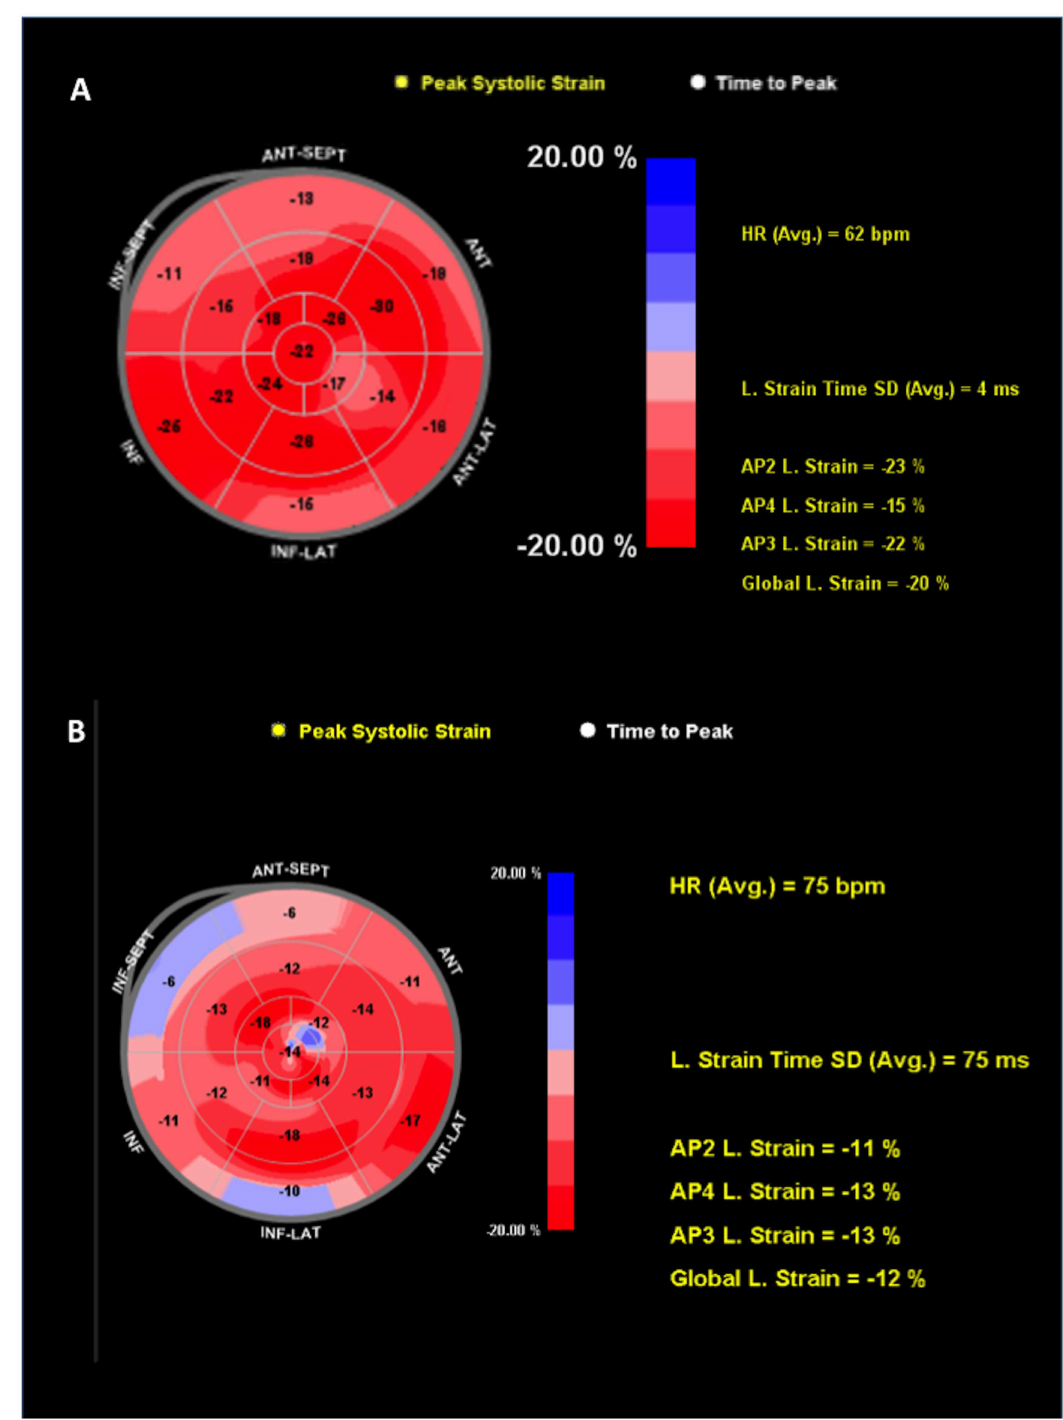
Fig 2. Examples of normal and abnormal polar plot strain maps. (A) Normal polar plot map (GLS -20%). (B) Abnormal polar plot map from a patient who developed PICMP by 12 months. GLS and TPS-SD measure-12% and 75ms respectively,indicating reducedgloballongitudinalstrain and LV dyssynchrony.